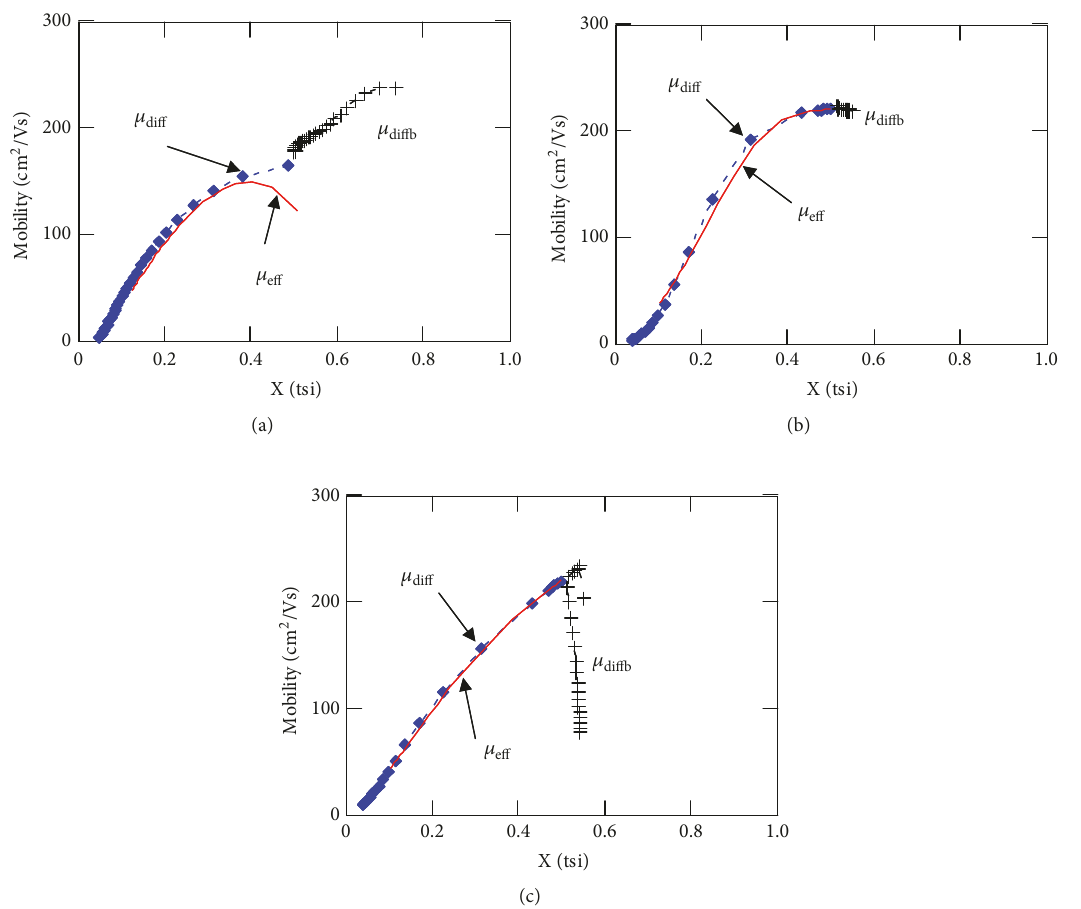
Figure 4: Variations of 𝜇 and global (c)